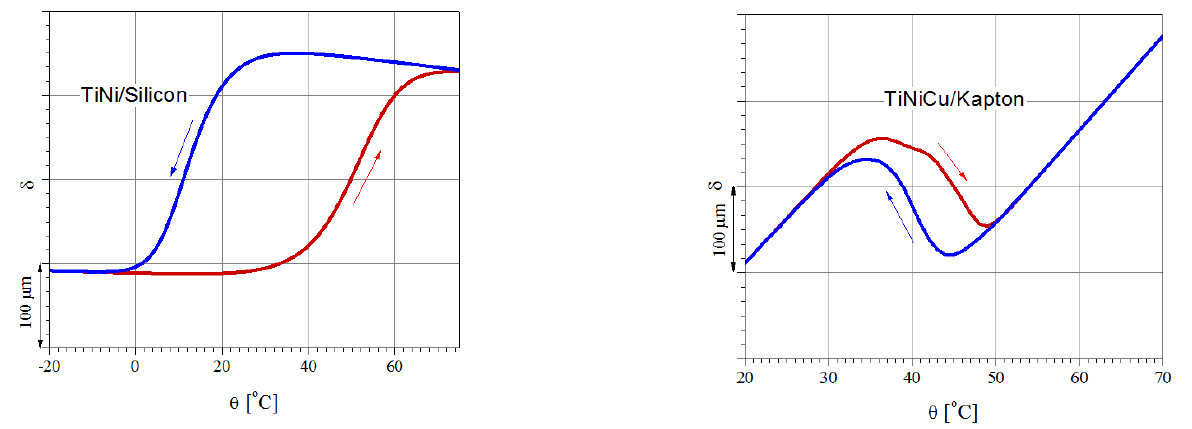
Figure 11. Actuation profile vs. temperature (deflection of the free end of bimorph cantilevers with NiTi and TiNiCu films deposited on different 100 µm-thick substrates, as predicted for 1 µm-thick film deposited at 550 °C and thermally cycled (( left ): NiTi/Si; ( right ) NiTiCu/Kapton; arrows indicate heating and cooling, respectively).